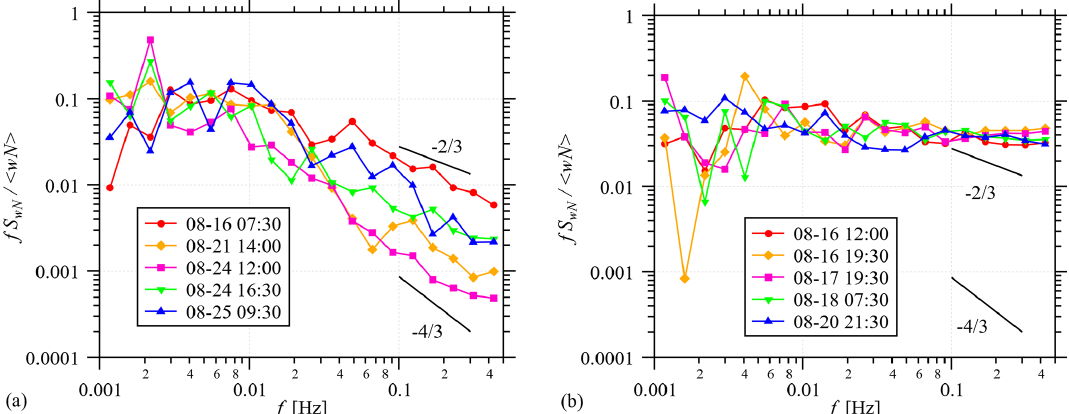
Figure 5. Select aerosol number flux spectra through the measurement period demonstrating spectra with (a) an identifiable inertial subrange and (b) an unresolved inertial subrange dominated by noise. N is the total number concentration (60nm to 1µm) and w is the vertical velocity. The power-law slopes of − 2 / 3 and − 4 / 3 are shown for comparison. The − 4 / 3 slope is predicted by theory and the − 2 / 3 slope is used for comparative